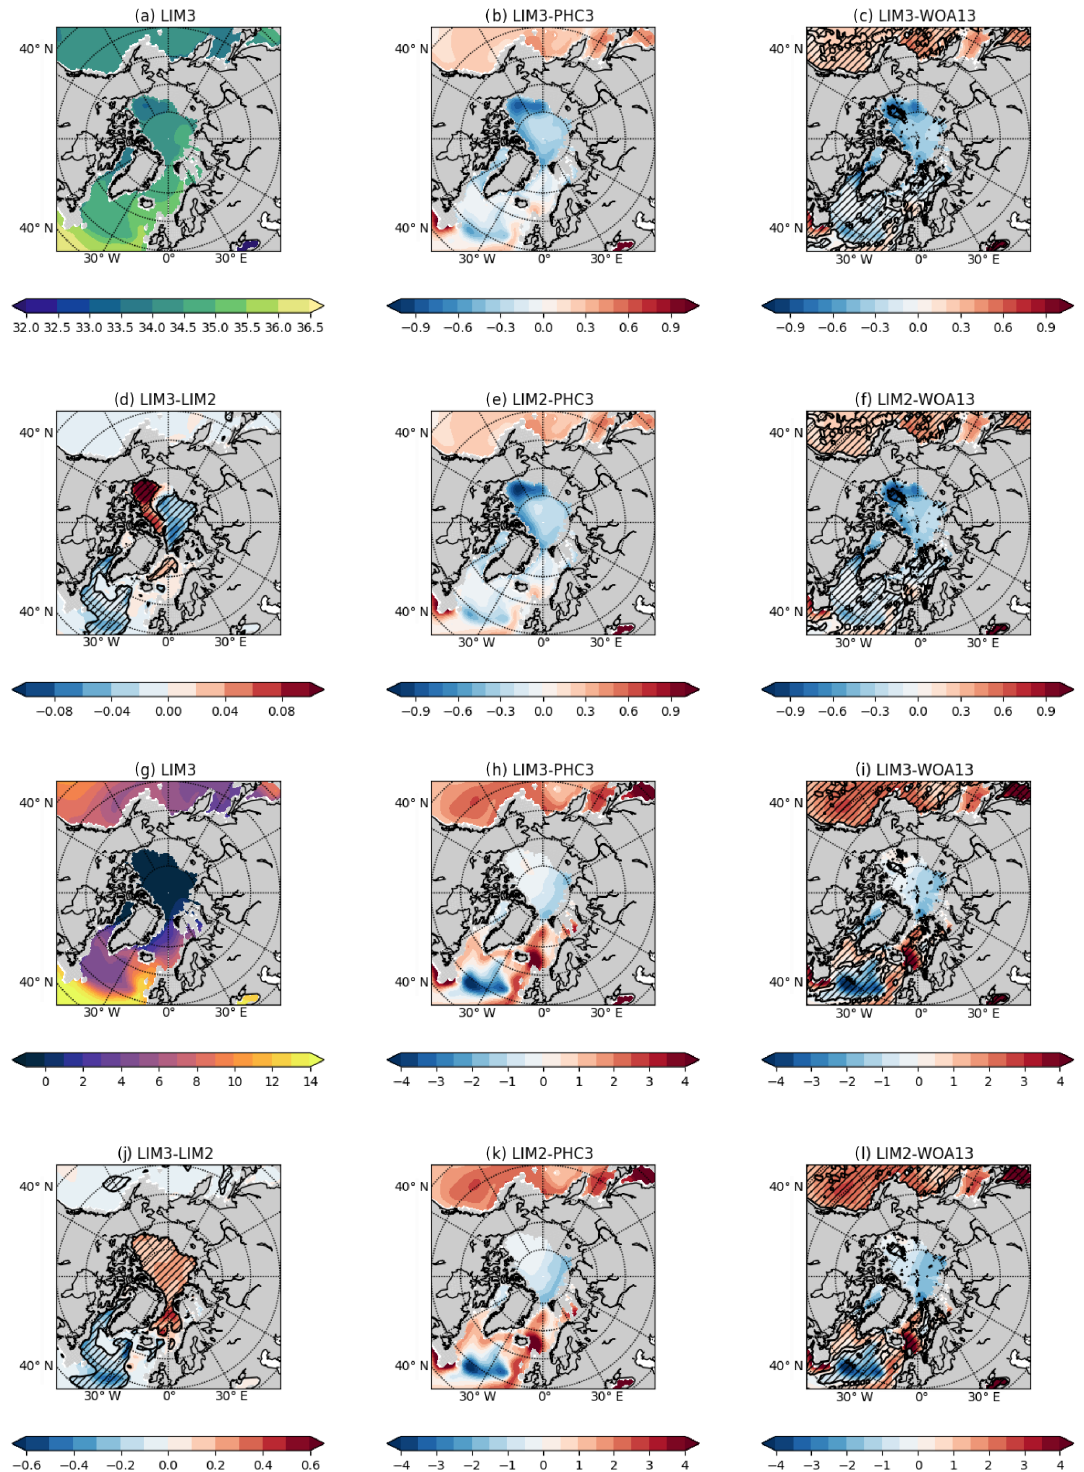
Figure 7. As Fig. 5, but for the Arctic Intermediate Water (AIW) at